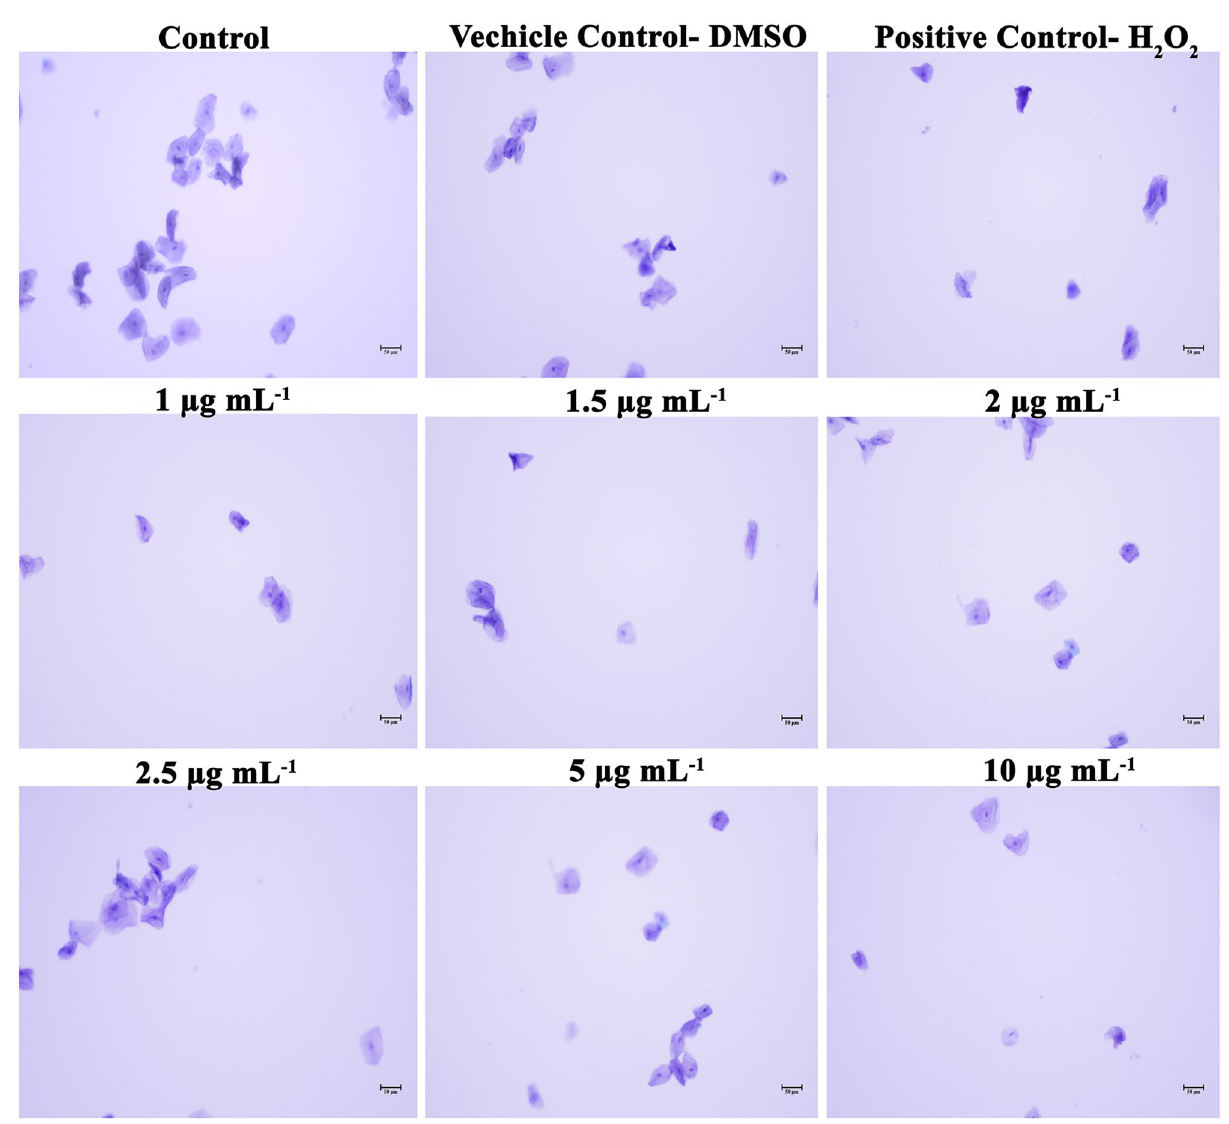
Figure 8. Nontoxic nature of UA to HBECS. HBECs were treated with 1 to 10 µg mL −1 of UA and the cells were found to be normal as compared with the control cells with no morphological aberrations. Whereas, H 2 O 2 treated cells were found to be wrecked and expression of various virulence factors in a cell density dependent manner and affects genetic competence and acid tolerance response 15,40 . UA treatment significantly reduced the expression of ComDE which allude that downstream targets and virulence attributes under the control of ComDE such as biofilm formation and acid tolerance are also influenced which is substantiated by the results of glycolytic pH drop assay, acid measurement and acidurity. Acidogenicity, the ability to produce acid from wide range of fermentable sugars and acidurity, the potential to survive in low acidic conditions are two remarkable capacity of S. mutans to initiate caries and progression of teeth erosion 41,42 . In the glycolytic pH drop assay, fermentation of glucose by S. mutans was found to be decreased upon UA treatment. From the acidurity results it has been corroborated that UA has the ability to act on survival of S. mutans cells that are adapted to survive under acidic condition. Kawari et al., have reported that under low pH conditions, S. mutans tend to form biofilm in an eDNA dependent manner 43 . Under Com- dependent biofilm formation at low pH conditions, as a stress response from the lysed cells, induction in eDNA release may be found. eDNA in the biofilm matrix acts as adhesives which further strengthen the biofilm 44,45 . Moreover, upregulation of biofilm formation is also correlated with the presence of eDNA 46 . Also, a mutant study reported that the deletion of vicR showed enhanced release of eDNA in the supernatant 47 . Remarkably, eDNA content in the UA treated biofilm conglomerate was completely repressed when compared to the eDNA from control. This could be due to the enhanced release of eDNA content to the external environment. Furthermore, UA precisely acted on the preformed mature biofilm of S. mutans. Smu0630 gene was demonstrated to play a role in biofilm formation and it has been suggested as a potential target for novel therapeutics 8 . Downregulation of Smu0630 by UA was observed. Downregulation of key players